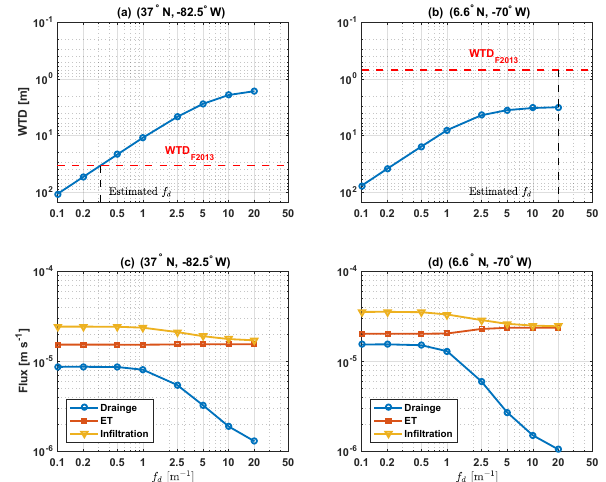
Figure 2. Transient liquid pressure simulated for a two-layer soil system by VSFM (solid line) and PFLOTRAN (square) for (a) wet- ting and (b) drying scenarios.